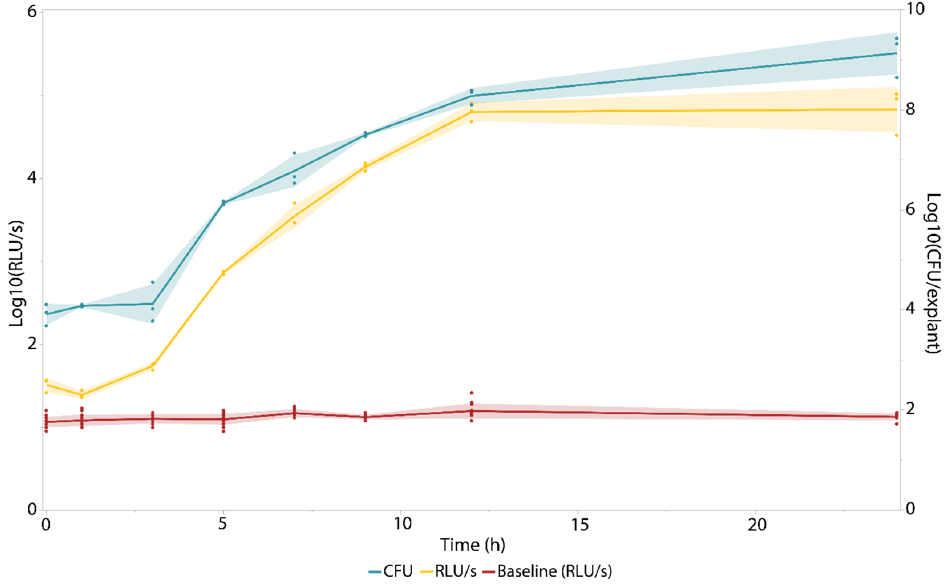
Figure 2. Growth of A. baumannii NCTC13423:: luxCDABE in the ex vivo pig skin burn wound model. Bacteria were recovered from the skin using a homogenizer, and a tenfold dilution series was made to determine the amount of colony forming units per explant (colony forming units per explant (CFU/explant), right y ‐ axis marked in teal). Then, the bioluminescence intensity of this homogenate was measured (expressed in relative light units per second (relative light units per second (RLU/s)), left y ‐ axis marked in yellow). The baseline (in red) indicates the detection limit of the bioluminescence measurements. Each time point consists of three biological replicates (n = 3), whereas the sample size of the baseline comprised nine replicates (n = 9) The error bands indicate one standard deviation from the mean.